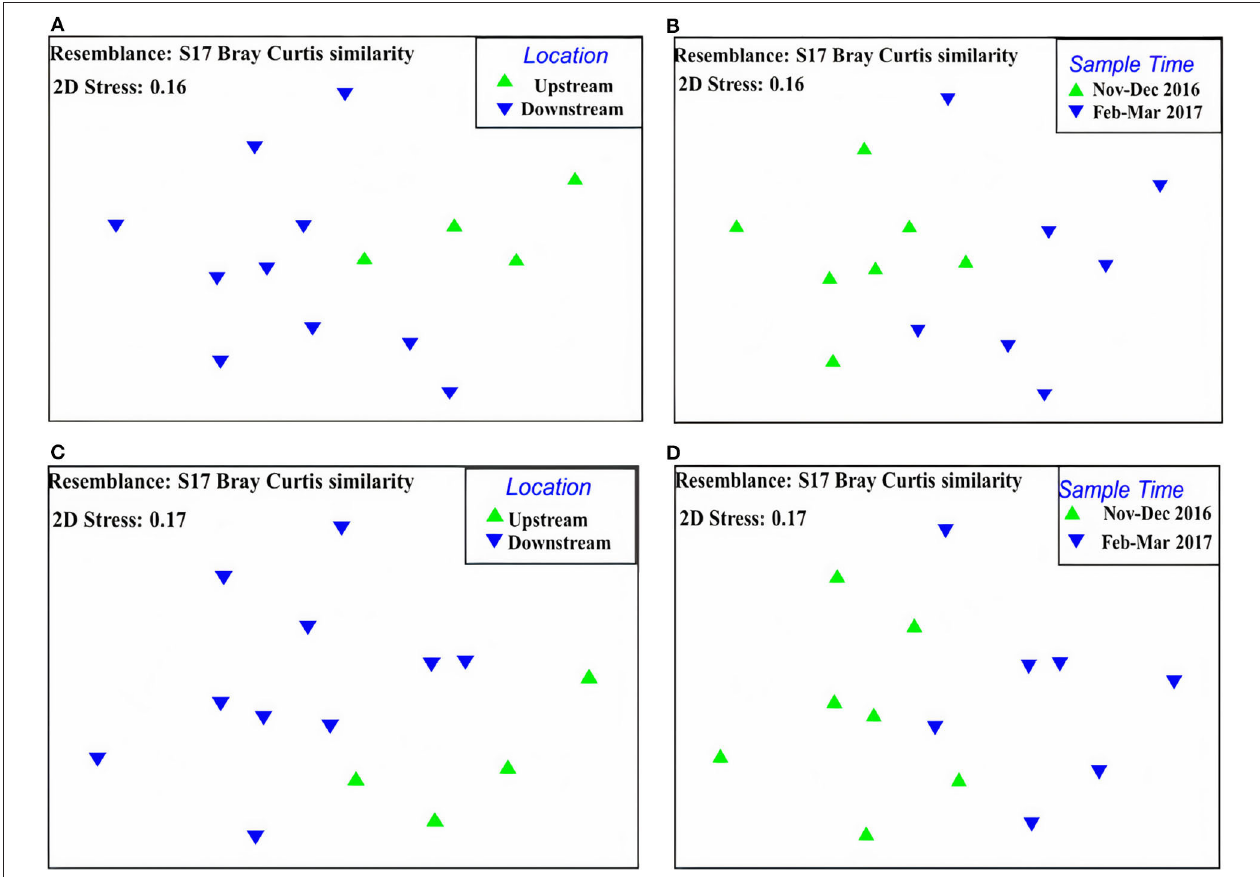
FIGURE 5 | Non-metric Multidimensional Scaling (MDS) plots for comparison of sampling sites (upstream and downstream) and sampling period (November–December 2016 and February–March 2017) in Chaungmagyi River, (A) : the comparison of all taxa communities between sampling sites, (B) : the comparison of all taxa communities between sampling periods, (C) : the comparison of EPTO taxa communities between sampling sites, (D) : the comparison of EPTO taxa communities between sampling periods.